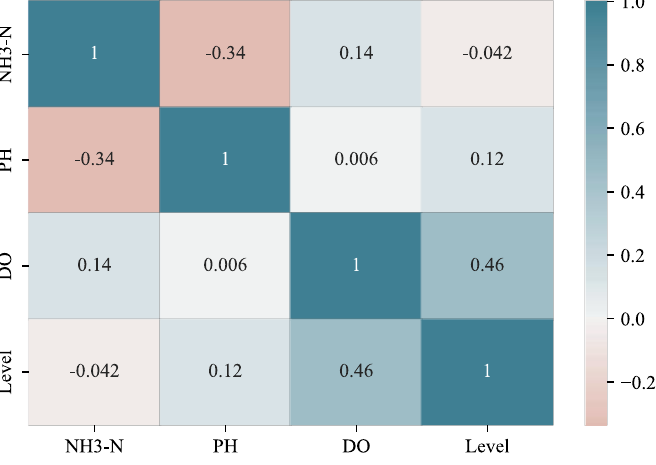
Figure 8. Distribution of water quality by season.